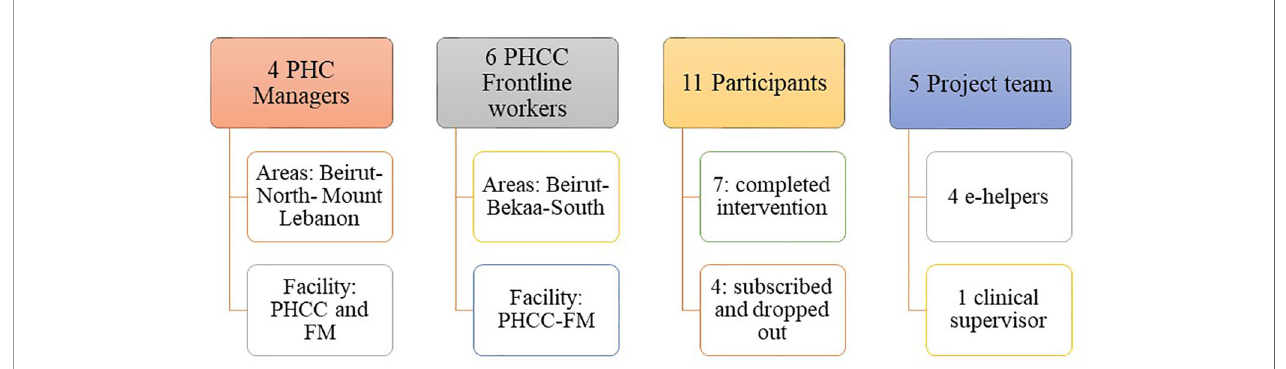
FIGURE 4 | Process evaluation participants